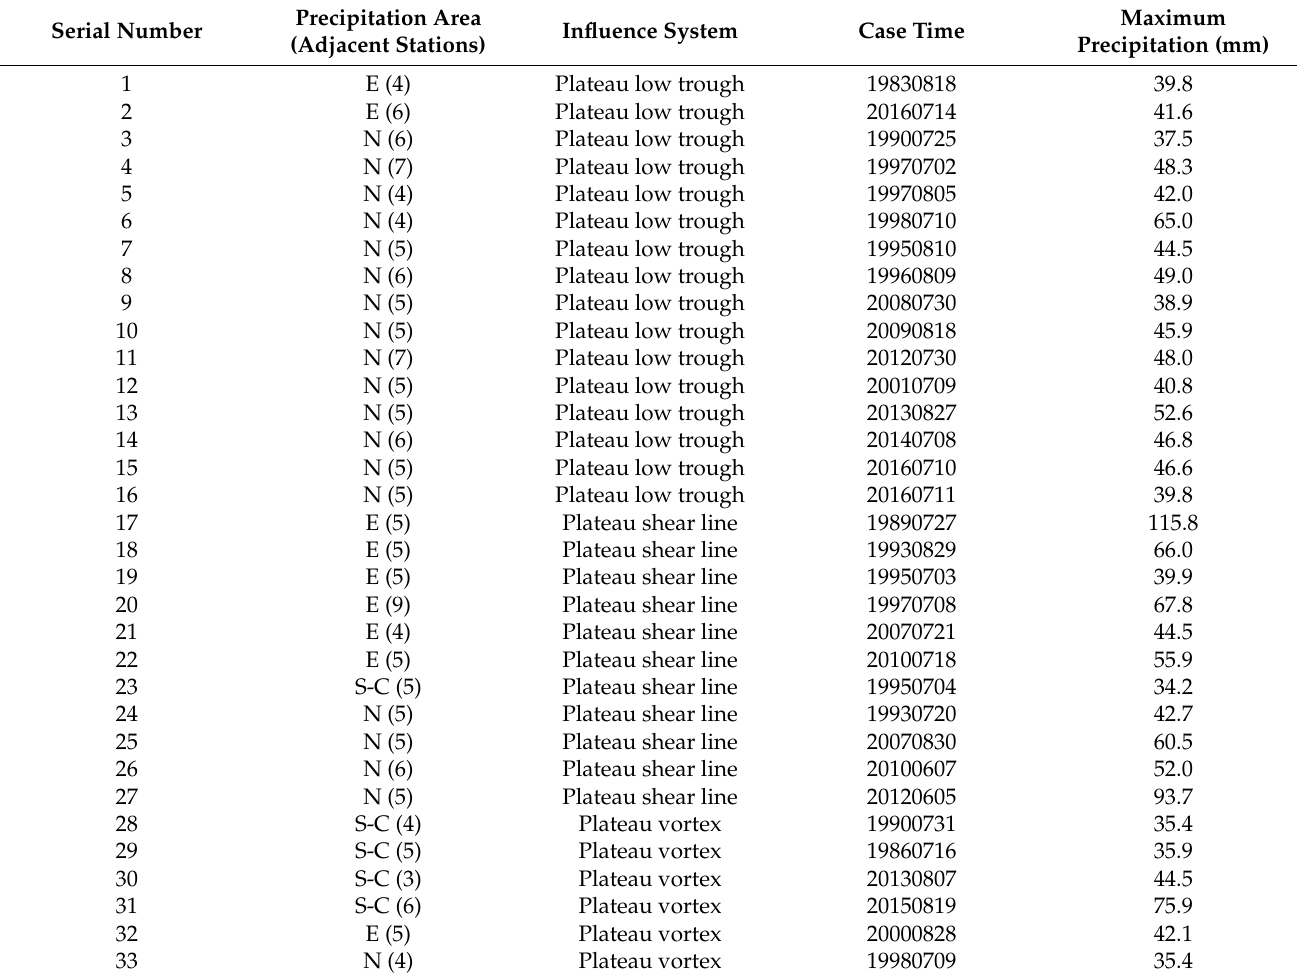
Figure 6. The frequency distribution of regional extreme precipitation events at each station. Table 1. The 500 hPa influence system of regional extreme precipitation events.